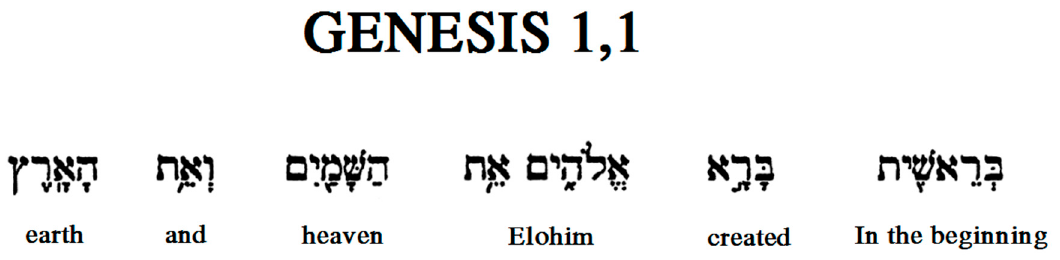
Figure 2. Book of Genesis , first verse: “In the beginning Elohim created Heaven and Earth.” (Gen 1,